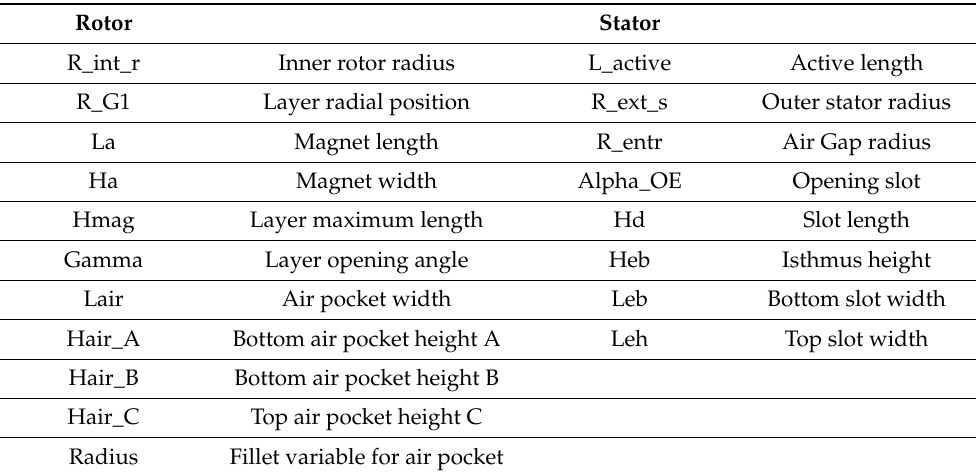
Table 1. Optimization parameters